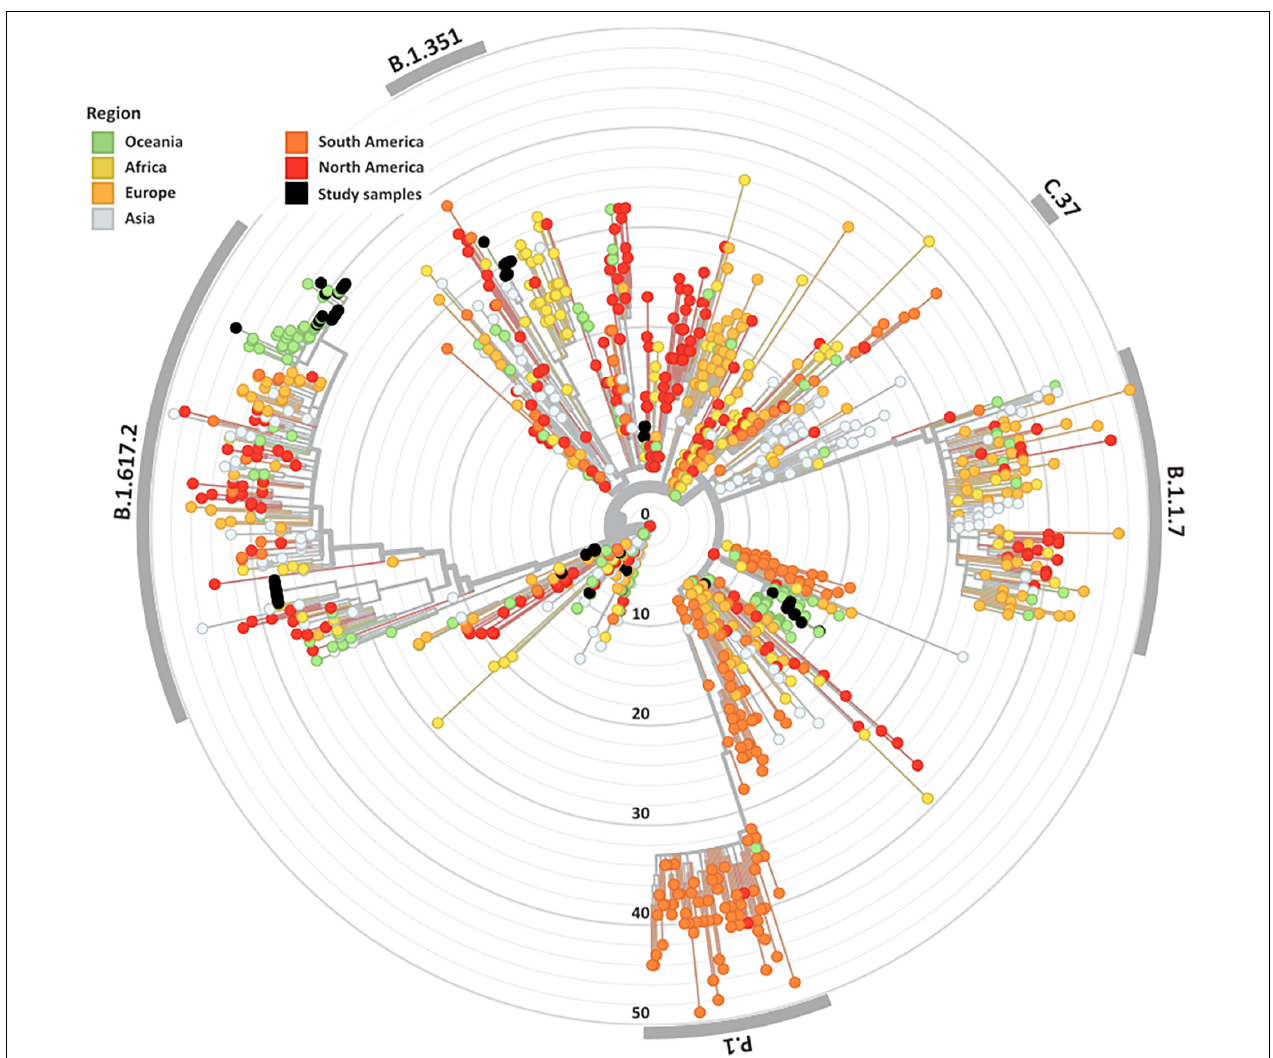
FIGURE 1 | Genomic and epidemiological diversity of clinical and culture SARS-CoV-2 sequences. The SARS-CoV-2 phylogeny was constructed in a local version of Nextstrain (auspice.us) and shows the evolutionary relationship of SARS-CoV-2 genomes sequenced within this study (black dots) and a subsample of publicly available SARS CoV-2 genomes collected globally ( n = 1,079). The tree branch lengths represent divergence, with sequences rooted relative to early samples collected in Wuhan, China